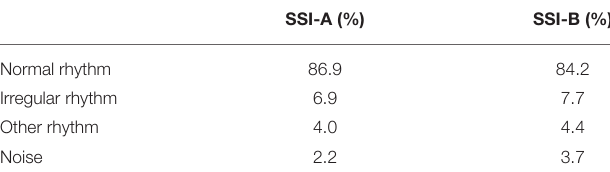
TABLE 1 | SSI-A and SSI-B composition after machine annotation.